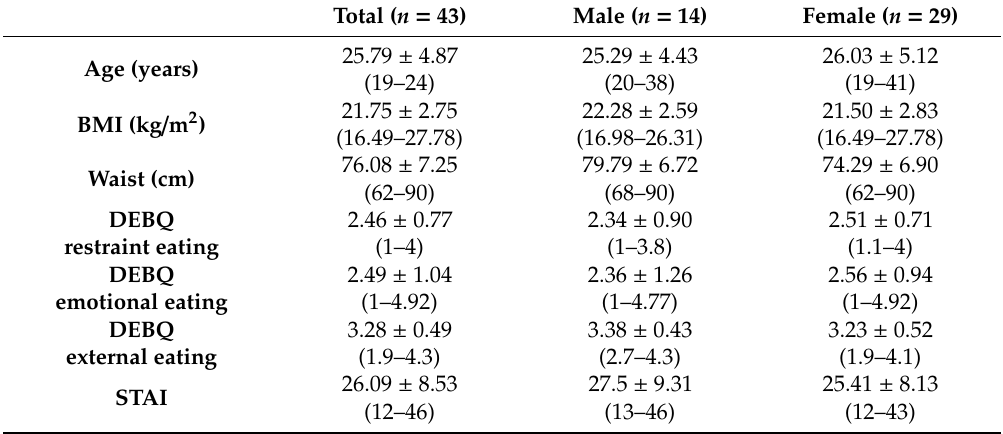
Table 3. Participant characteristics (results expressed as mean ± SD, and range (min and max) indicated in parentheses).